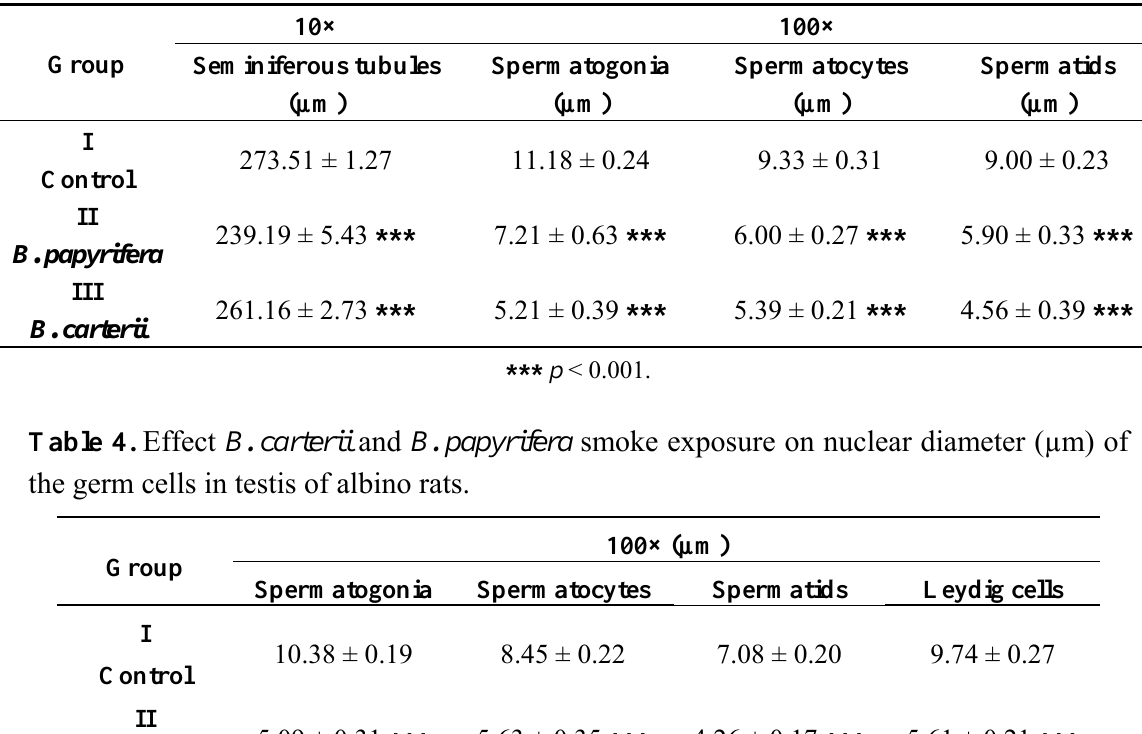
Table 3. Effect B. carterii and B. papyrifera smoke exposure on diameter of seminiferous tubules, germ cells (µm) in the testis of albino rats.